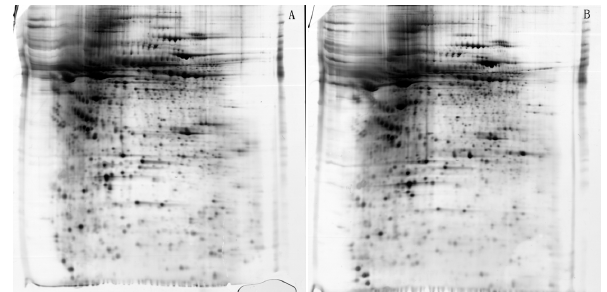
Figure 1. Analysis of plasma proteins before and after risperidone treatment using 2-DE. 1st-dimension: separation of isoelectric focusing (IEF), immobilized pH gradient (IPG) strips PH3-10, non-linear. 2nd-dimension: SDS-polyacrylamide gels (SDS-PAGE), 18 cm 8–16% gradient gels. Proteins were visualized using silver staining. A: Before treatment. B: After treatment.